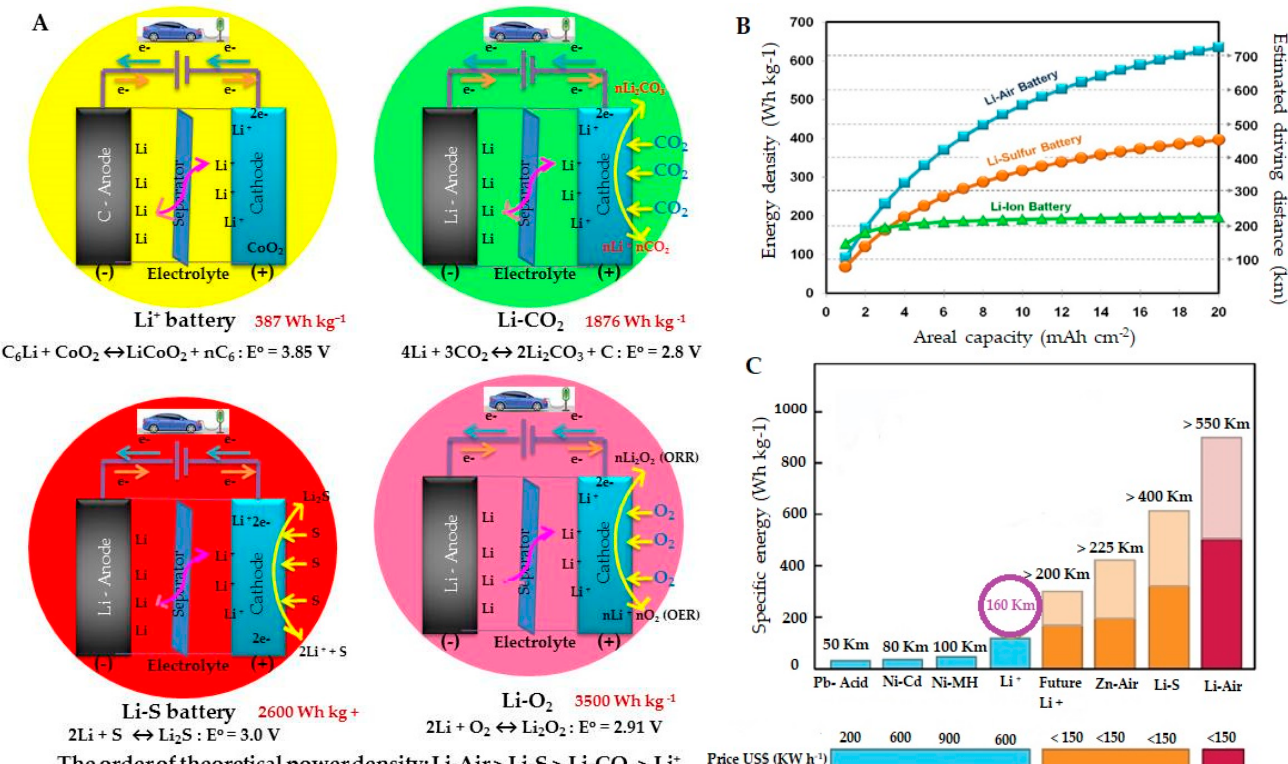
Figure 1. ( A ) The emerging batteries based on Li: Li + battery, Li-CO 2 battery, Li-S battery, and Li-O 2 batteries and their theoretical power densities. Except for the Li + battery, the rest of the inventions are still at the R & D level. ( B , C ) are different rechargeable batteries with their specific energies, areal capacity, and their mileages along with their status of prices and development. Reprinted/adapted with permission from Refs. [31,32]. Copyright 2020, copyright SCI Reports, and Copyright 2017, copyright Table 1. Comparison of the best performing Li based batteries.